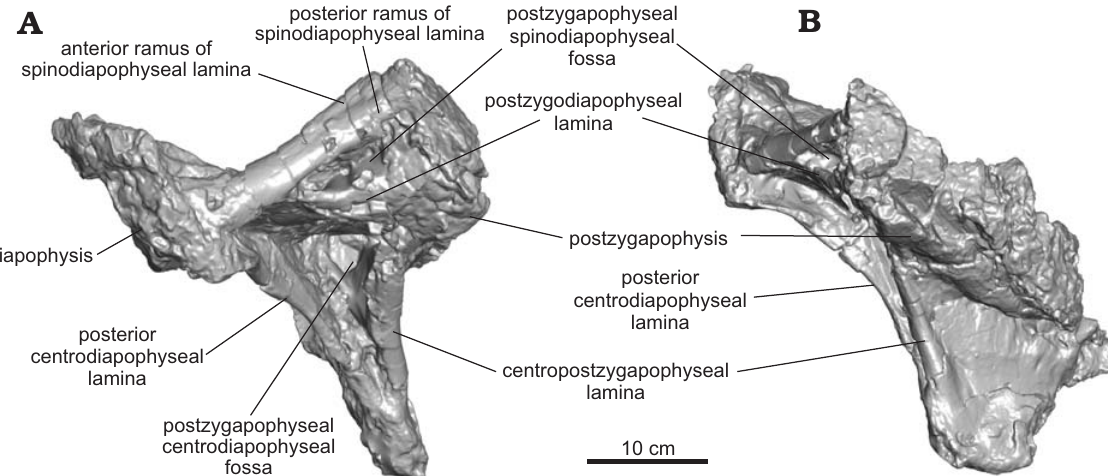
Fig. 7. Partial neural arch of titanosaurian sauropod Dreadnoughtus schrani Lacovara, Lamanna, Ibiricu, Poole, Schroeter, Ullmann, Voegele, Boles, Carter, Fowler, Egerton, Moyer, Coughenour, Schein, Harris, Martínez, and Novas, 2014 (MPM-PV 1156?-7), from Santa Cruz Province, Argentina; middle–late Campanian to early Maastrichtian; in left lateral ( A ) and posterior ( B )